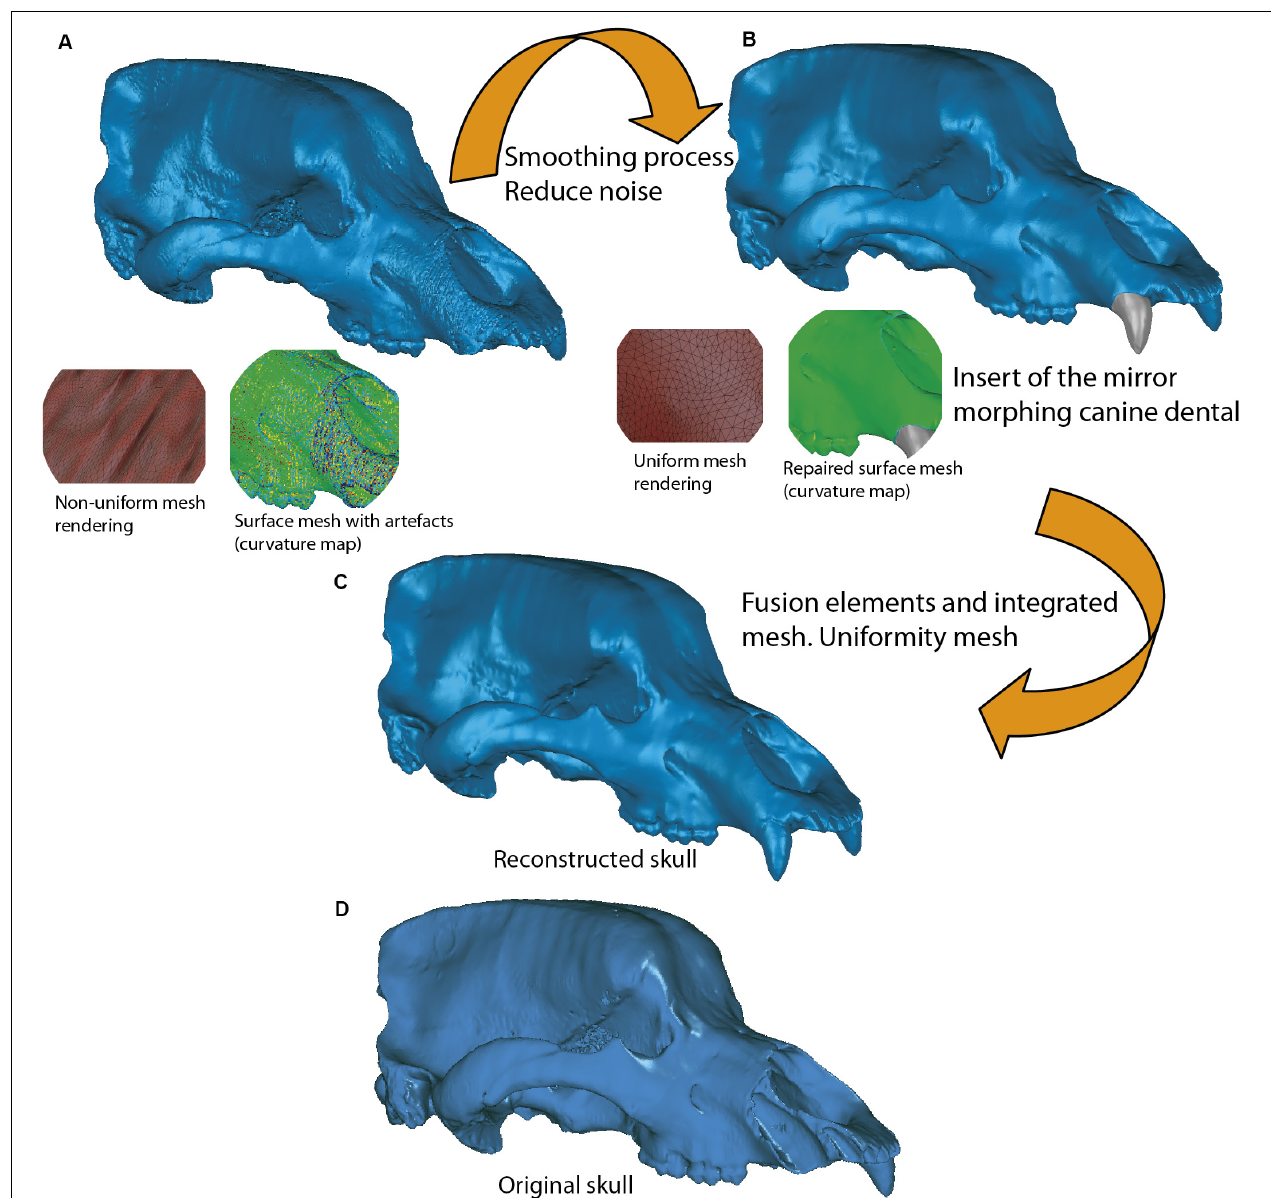
FIGURE 10 | Example of mesh tessellation and decimation using the dataset of Ursus ingressus (PIUW3000/5/105) as an example. (A,B) First step of mesh postprocessing and smoothing, based on the decimated density of mesh triangulation. (B,C) Second step of mesh postprocessing, consisting of the fusion and integration of different elements, being in this case the lacking teeth. (C) Final step of mesh postprocessing, consisting of noise deletion in the mesh by special tool, Uniformity mesh. (D) Original mesh of the skull before of the reconstruction